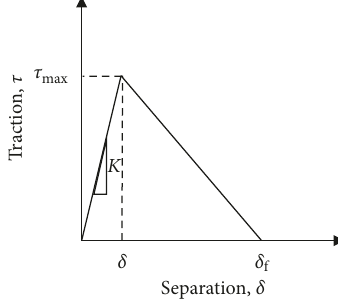
Figure 16: Traction-separation cohesive material